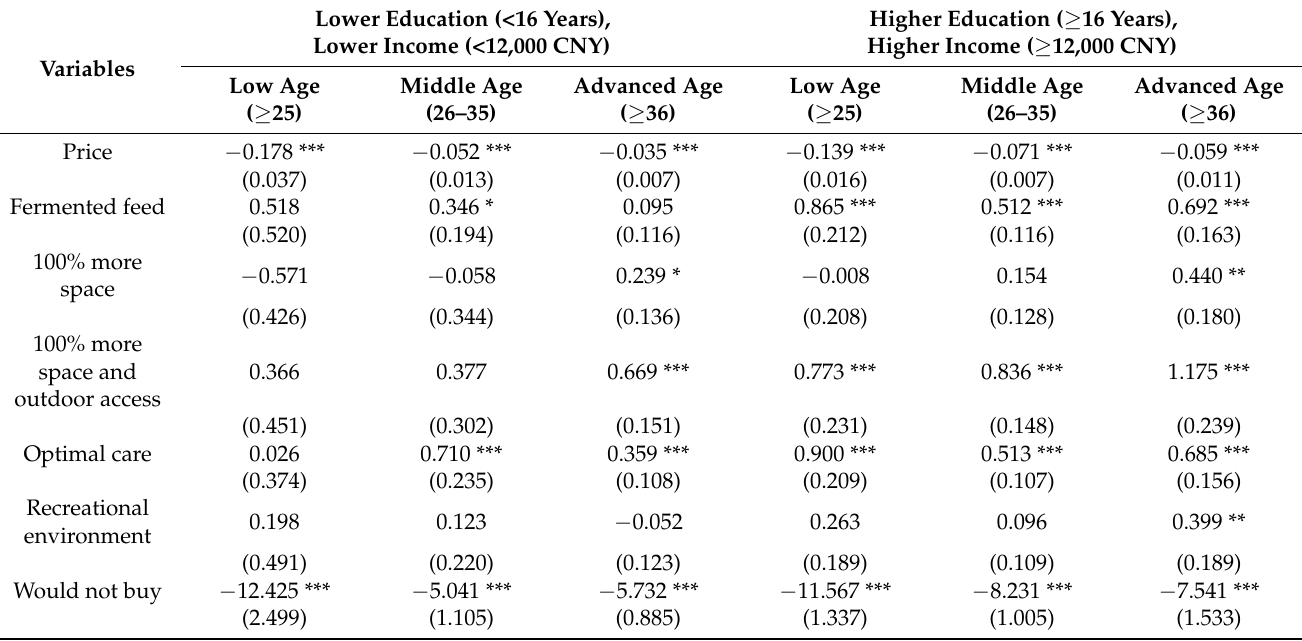
Table 5. Random parameter logit results of consumer preferences by six